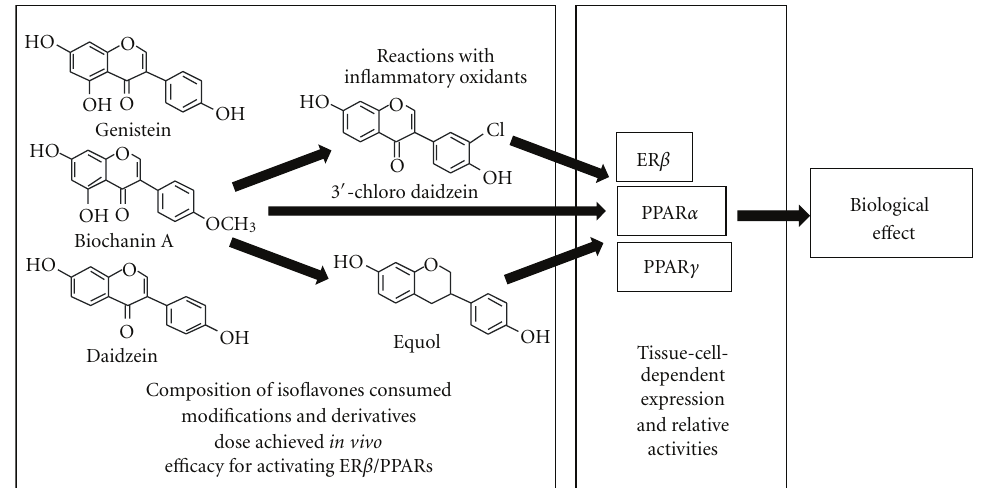
Figure 5: Regulation of isoflavone-dependent activation of PPAR signaling. Isoflavone consumption has been shown to activate ER β -, PPAR α -, or PPAR γ -dependent signaling pathways and in this way may exert control over diverse biological processes that are associated with health benefits of consuming these compounds. Summarized in this figure are the key factors that likely control how isoflavones modulate signaling. The core 7-hydroxy-benzopyran-4-one structure has recently been shown to be important for PPAR α and PPAR γ activation, and importantly this core is present in many plant-derived isoflavones that comprise natural and commercial preparations (shown are the structures of genistein, daidzein, and biochanin A as examples). Also indicated is the 7-hydroxy group on the A-ring that has been shown to be critical for PPAR α and PPAR γ activation [13, 14]). Modification of isoflavones, for example, via reactions with inflammatory oxidants can form a variety of halogenated isoflavones which in turn can alter the e ffi cacy of isoflavone-dependent activation of signaling (shown as an example is 3 (cid:2) -chlorodaidzein). Note that multiple positional isomers of chlorine and bromine (other endogenous halogens and nitration products are possible [13, 61–63]. Moreover, gut microflora metabolism has been shown to be important in producing equol from daidzein and may have cardiovascular protective e ff ects. We propose that a better understanding of isoflavone metabolism, the modifications that occur, and how they influence activation of ER/PPAR pathways is central to elucidating molecular mechanisms by which these compounds a ff ect disease. Additional and important factors that will dictate the biological response to isoflavonesinclude expression profiles and relative activities and interactions between of ER β -, PPAR α -, and PPAR γ -dependent